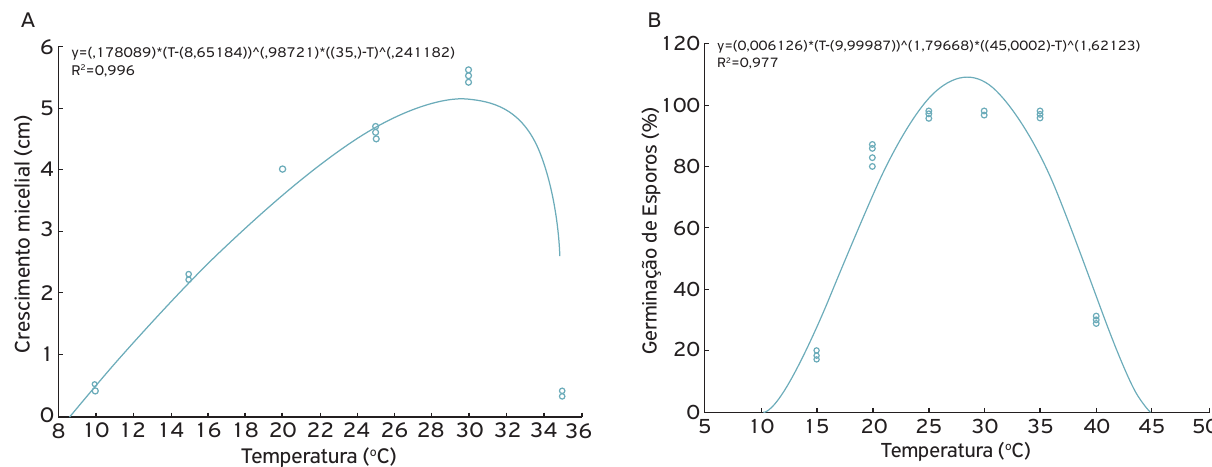
Figura 1. (A) Diâmetro médio de colônias e (B) porcentagem de esporos germinados de Corynespora cassiicola de Malpighia emarginata , submetidos a diferentes